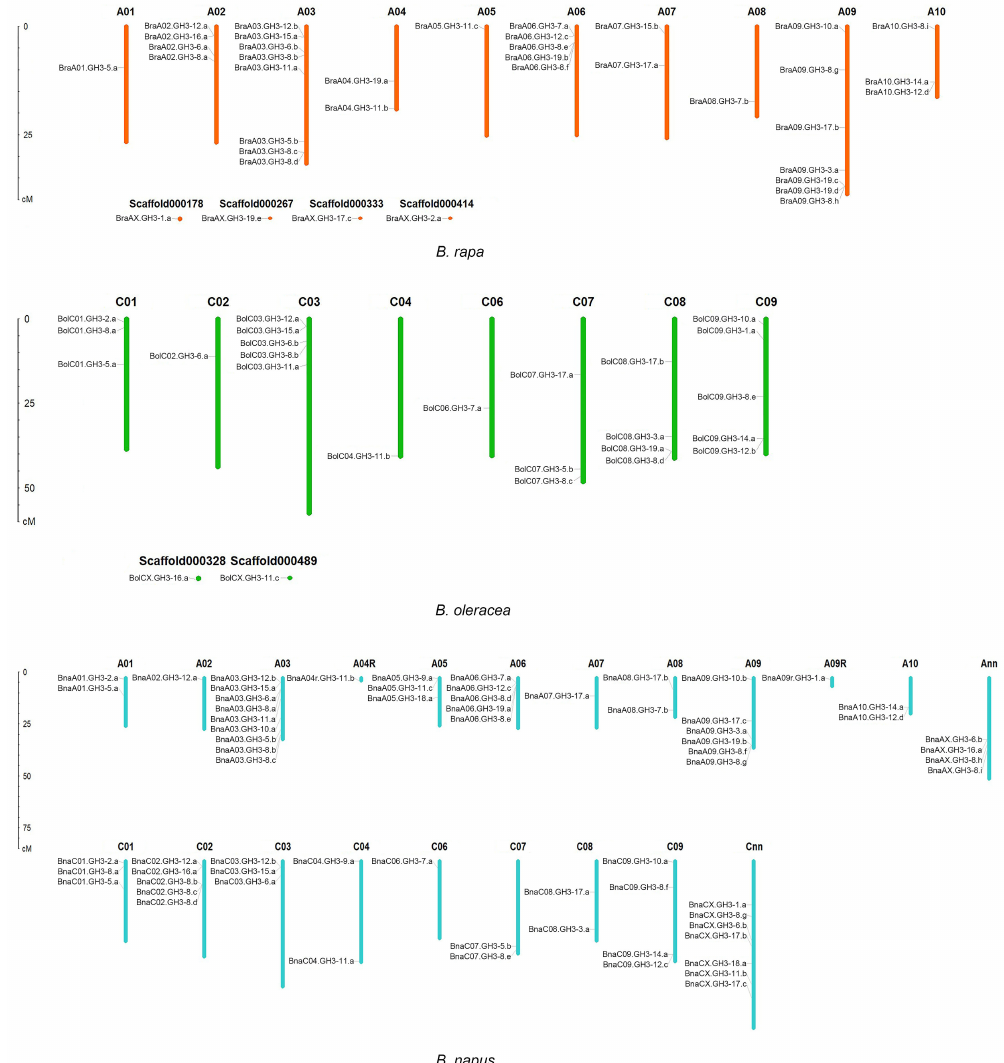
Figure 1. The chromosomal location of GH3 genes in the three species of Brassica . Scaffords: assembled sequence that failed to be incorporated into the chromosomes; A04R means A04-random; A09R means A09-random; A04-random and A09-random: the specific positions of genes on A04 and A09 are still unknown; A nn means A nn -random; C nn means C nn -random; A nn -random and C nn -random: unmapped A chromosomes of B. napus genome and unmapped C chromosomes of B. napus